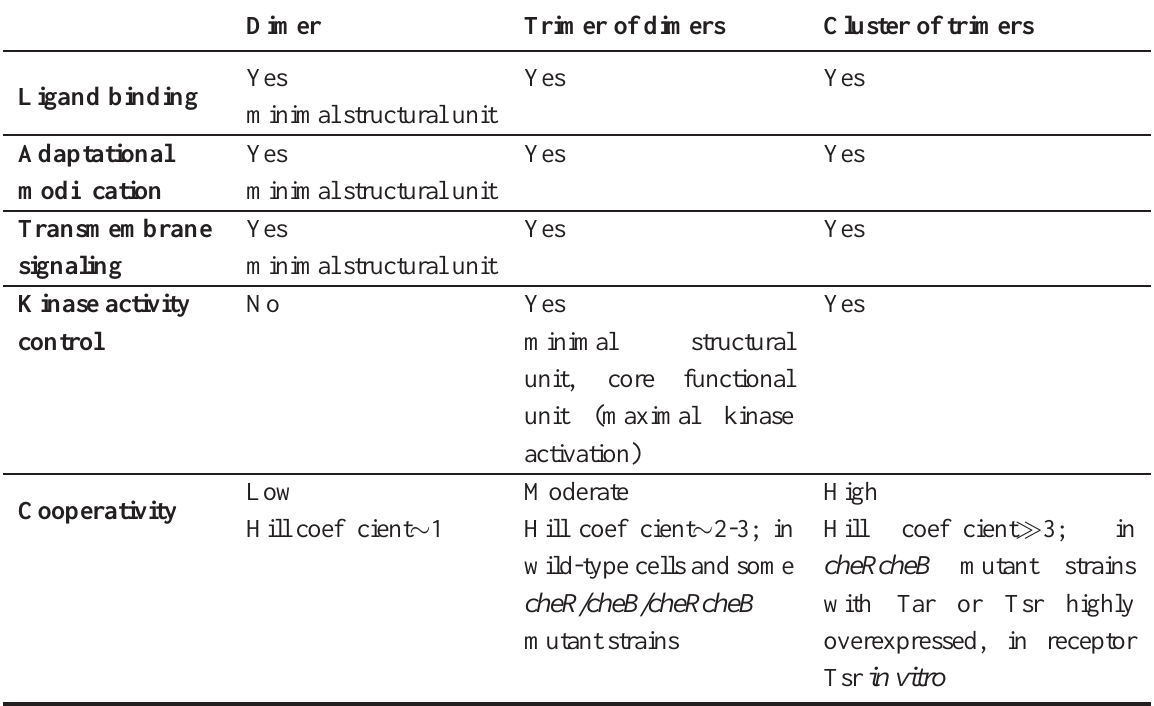
Table 1. Structure-function relationship of chemoreceptor clusters in E. coli